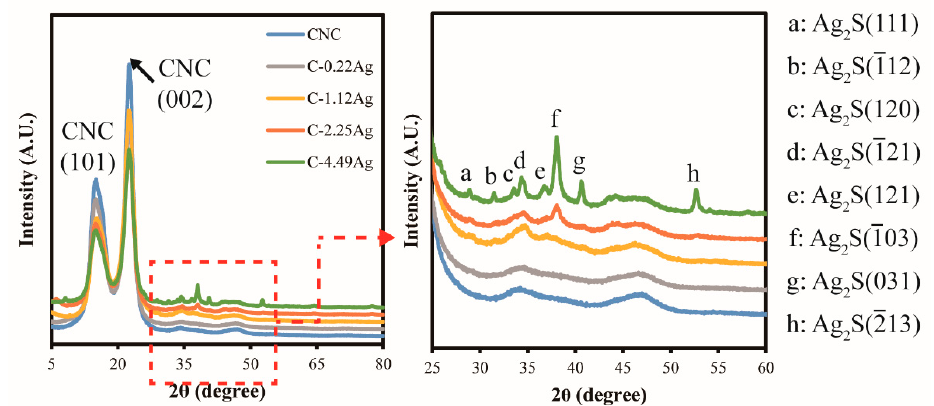
Figure 10. XRD patterns of tested CNC and CNC-AgNP films.